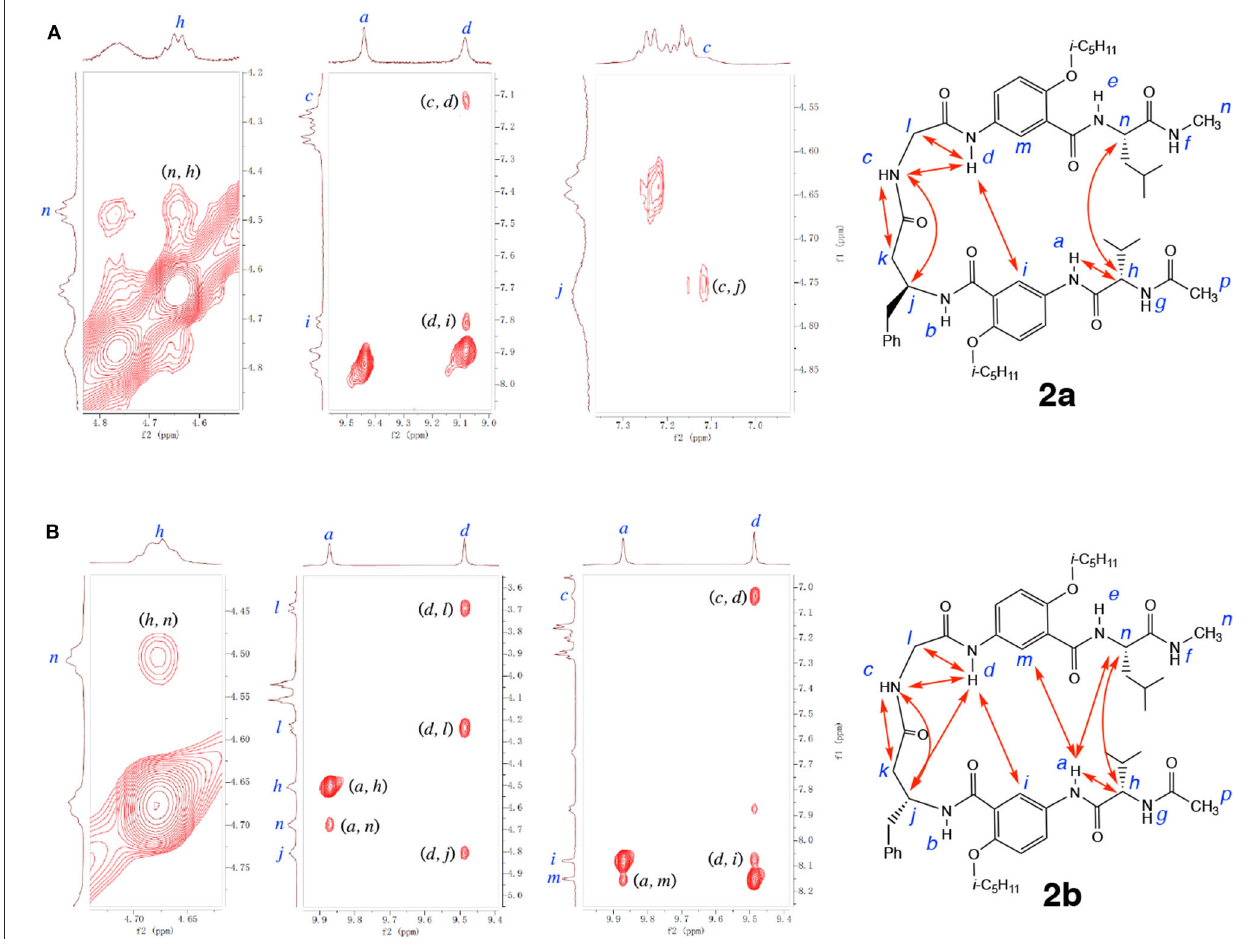
FIGURE 8 | Partial NOESY spectra of (A) hexapeptide 2a (5mM), and (B) hexapeptide 2b (5mM) in 1, 1, 2, 2-tetrachloroethane- d 2 containing 5% DMSO- d 6 (600 MHz, 298K, mixing time: 300ms). Major NOEs are indicated by double-headed arrows in the structures. Partial NOESY spectra showing NOEs between protons a and h , c and k , and d and l of 2a , and between protons c and k , and c and j of 2b , are included in the Supplementary Materials .